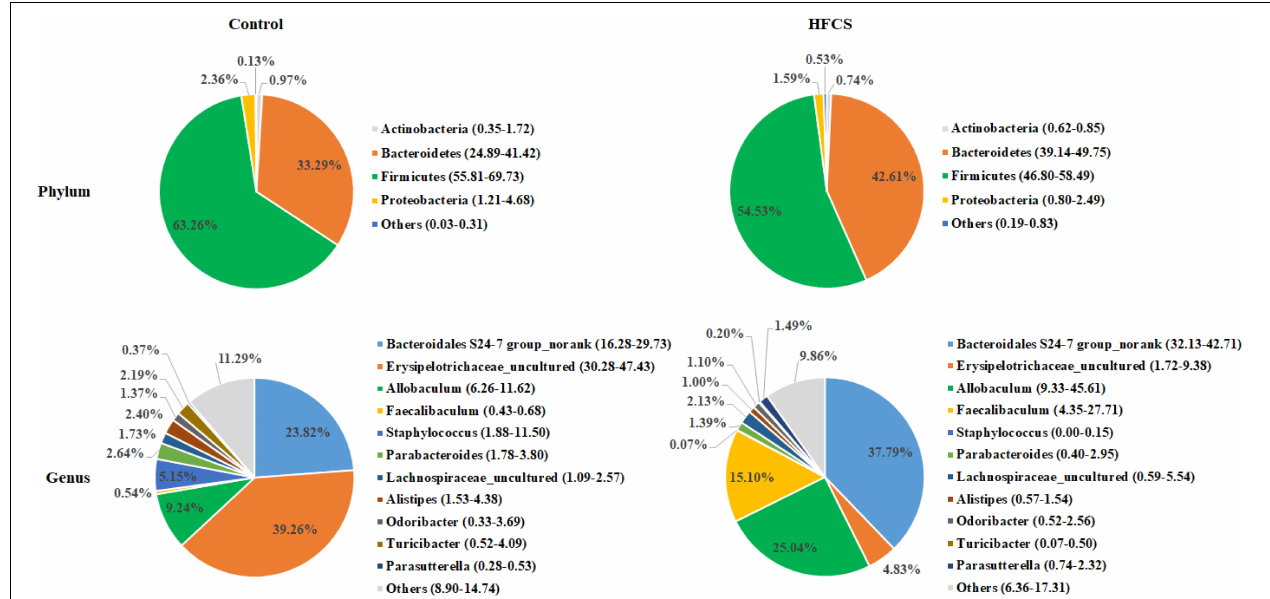
FIGURE 7 | Phylum- and genus-level pie charts of the structure of the intestinal microflora in control and HFCS-fed mice (n =